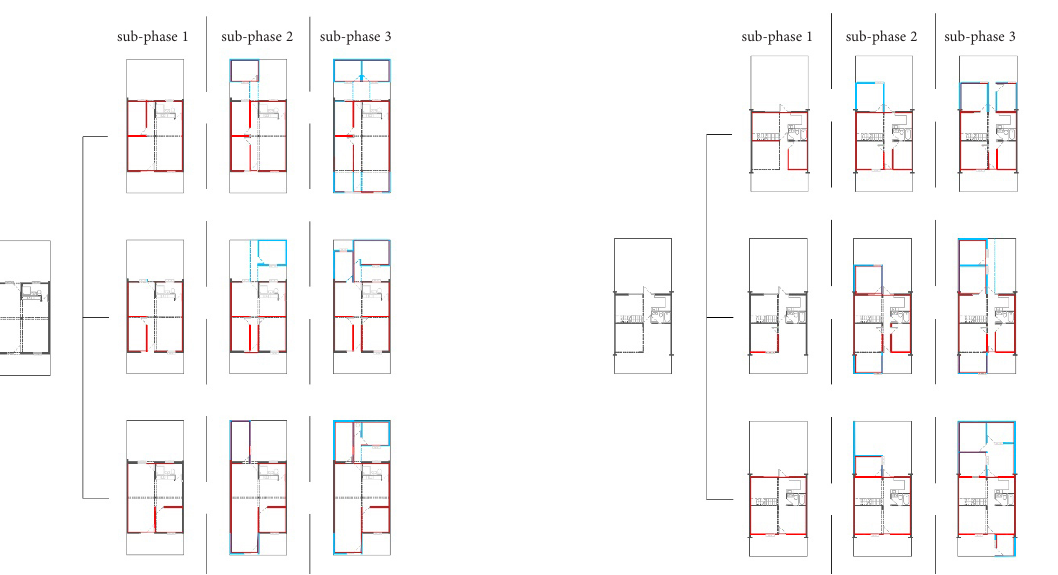
Figure 6. The design template of Lo Espejo first floor houses, customisation within frame of delivered houses (red); extensions of houses (blue) (source: the author)